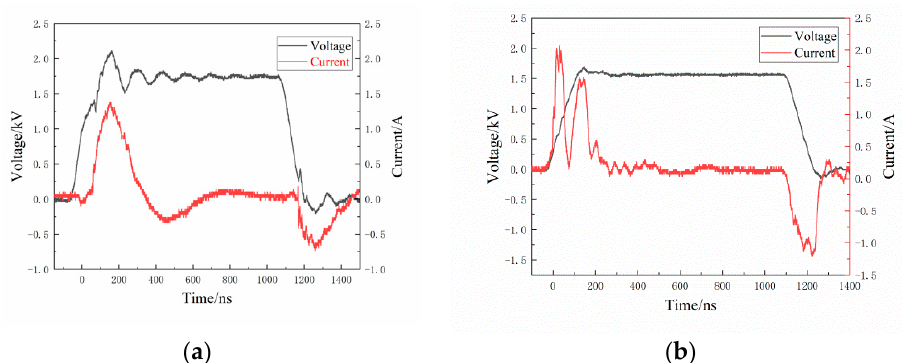
Figure 7. Discharge waveforms of nanosecond-pulsed dielectric-barrier discharge at pressures of ( a ) 3 kPa and ( b ) 7 kPa.